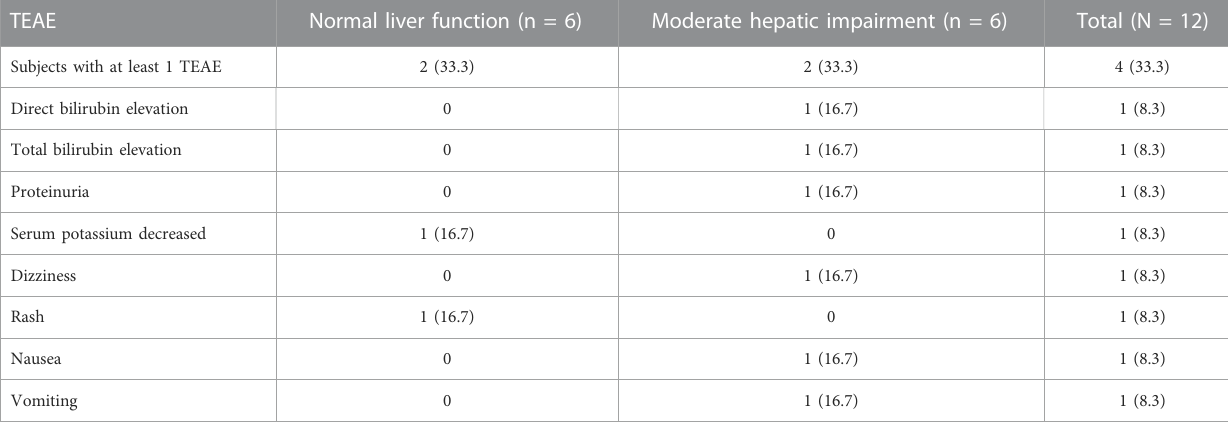
TABLE3Incidence oftreatmentemergentadverseeventsafterasingle oraldoseadministrationof800 mgcontezolid comparedbetweenpatientswith moderate hepatic impairment and healthy controls with normal liver function.